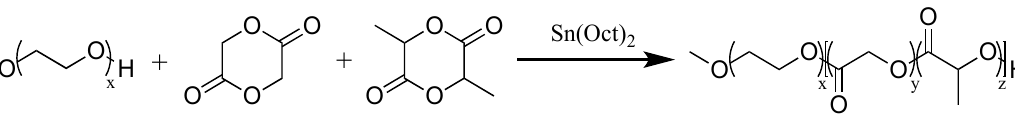
Figure 1. Synthesis of PEG- b -PLGA diblock copolymer.